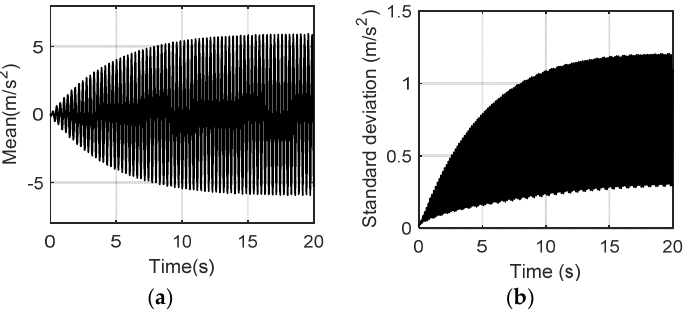
Figure 9. The mean and the standard deviation time history of the mid—span acceleration: ( a ) Mean; ( b ) Standard deviation.